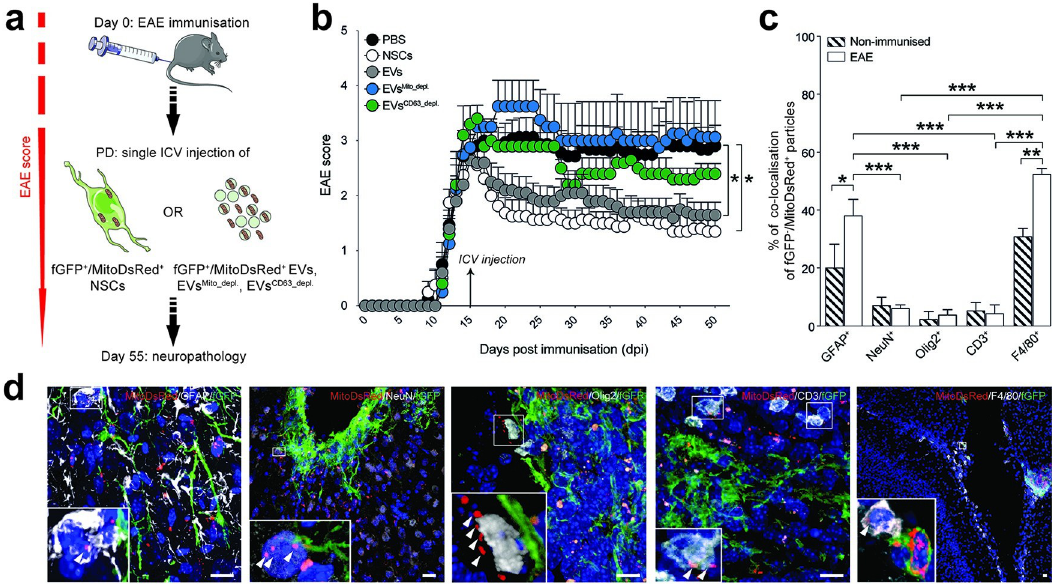
Fig 9. Transplanted NSCs transfer mitochondria to mononuclear phagocytes and astrocytes during EAE in vivo. (a) In vivo experimental setup of EV and NSC treatment in EAE mice. At PD, mice received a single ICV injection of either fGFP + /MitoDsRed + NSCs, EVs derived from fGFP + /MitoDsRed + NSCs (EVs), or fGFP + /MitoDsRed + EVs depleted of mitochondria (EVs Mito_depl. ), or fGFP + /MitoDsRed + EVs depleted of CD63+ EVs (EVs CD63_depl. ). Behavioural analysis was carried out daily until the end of the experiment. Neuropathology was performed at 55 dpi. (b) Behavioural outcome showing significant amelioration of the EAE score in mice treated with EVs ( N = 5) and NSCs ( N = 5), but not in EAE mice treated with EVs Mito_depl. ( N = 4) or EVs CD63_depl. ( N = 5) vs. PBS ( N = 8). Data are mean values ( ± SEM). � p < 0.05. (Data available in S3 Data). (c) Percentage of fGFP - /MitoDsRed + particles co-localising with GFAP + astrocytes, NeuN + neurons, Olig2 + oligodendrocytes, CD3 + T cells, or F4/80 + mononuclear phagocytes. fGFP + /MitoDsRed + NSCs were injected ICV into EAE mice (white bars) and in nonimmunised control mice (hatched bars). Data are mean values ( ± SEM) from N = 4 biological replicates. � p < 0.05, �� p < 0.01, ��� p < 0.001. (Data available in S3 Data). (d) Representative pictures of mitochondrial transfer events detected with confocal imaging (maximal projection). Transfer of MitoDsRed + particles (arrowheads) is shown between fGFP + /MitoDsRed + NSCs and GFAP + astrocytes (cortex), NeuN + neurons (cortex), Olig2 + oligodendrocytes (corpus callosum), CD3 + T cells (meninges), or F4/80 + mononuclear phagocytes (IV ventricle). Long processes of NSCs can be seen in green, while nuclei are stained with DAPI (blue). Scale bars: 20 μ m. DAPI, 4 0 ,6-diamidino- 2-phenylindole; dpi, days post immunisation; EAE, experimental autoimmune encephalomyelitis; EV, extracellular vesicle; ICV, intracerebroventricular; NSC, neural stem cell; PD, peak of